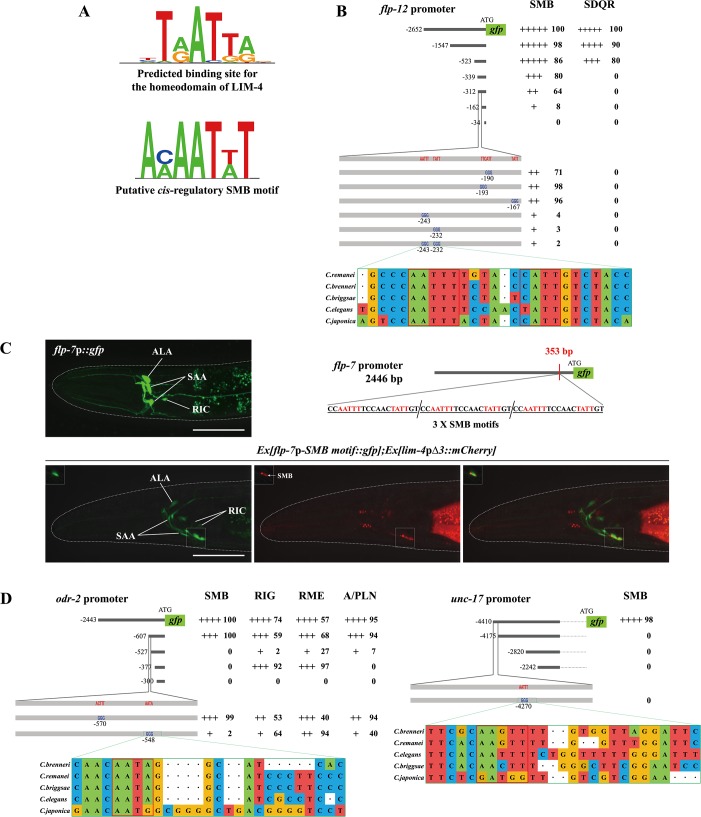
A cis-regulatory motif is necessary and sufficient to drive expression of terminally differentiated SMB markers.(A) Shown are the predicted binding site (top) for the homeodomain of LIM-4 from a web based tool, PreMoTF (http://stormo.wustl.edu/PreMoTF) [33] and the putative cis-regulatory SMB motif (bottom) identified from promoter analysis of flp-12, odr-2, and unc-17 genes. (B) The percentage of transgenic animals expressing flp-12p:: gfp reporter construct in the indicated neurons is shown. Strength of GFP expression is indicated by the number of + symbols. Wild-type nucleotides are indicated in red, mutated nucleotides in blue. At least two independent extrachromosomal lines for each construct were examined except a flp-12 promoter (-2652) construct of which number was derived from one integrated line. n≥50 for each. Identified cis-regulatory sequences found in other Caenorhabditis species are shown below. Analysis between -523 bp and -339 bp upstream of flp-12 promoter is shown in S10 Fig. (C) Insertion of the SMB motif into the non-SMB expressed flp-7 gene promoter induces flp-7 expression in the SMB neurons. The inserted cis-regulatory sequences identified from the flp-12 promoter analysis and the inserted site in the flp-7 promoter are indicated. GFP expression is overlapped with expression of the lim-4pΔ3::mCherry reporter in the SMB neurons of wild-type animals. Images are derived from z-stacks of confocal microscopy images while images in the upper-left boxed regions are single focal plane confocal microscopy images. Anterior is to the left. Scale bars: 50 μm. (D) The percentage of transgenic animals expressing odr-2p::gfp or unc-17p::gfp reporter construct in the indicated neurons is shown. Strength of GFP expression is indicated by the number of + symbols. Wild-type nucleotides are indicated in red, mutated nucleotides in blue. At least two independent extrachromosomal lines for each construct were examined. n≥50 for each. Identified cis-regulatory sequences found in other Caenorhabditis species are shown below.